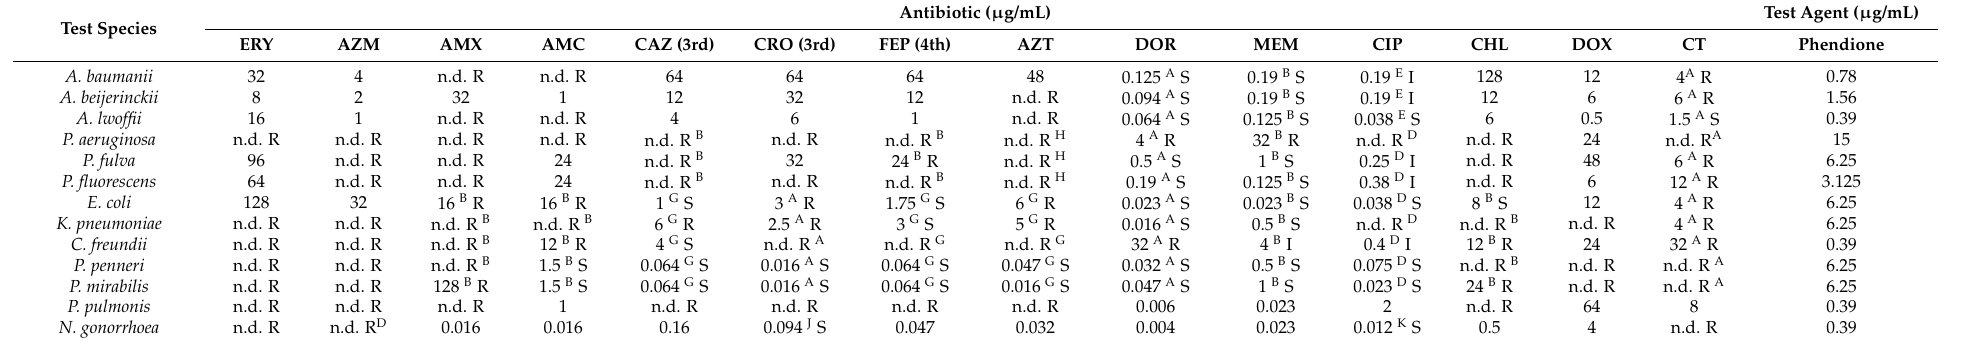
Table 2. MIC results for test species for selected antibiotics and test agent phendione based on EUCAST microdilution plate assay, where MICs for N. gonorrhoea were based on gradient test strips and agar dilution